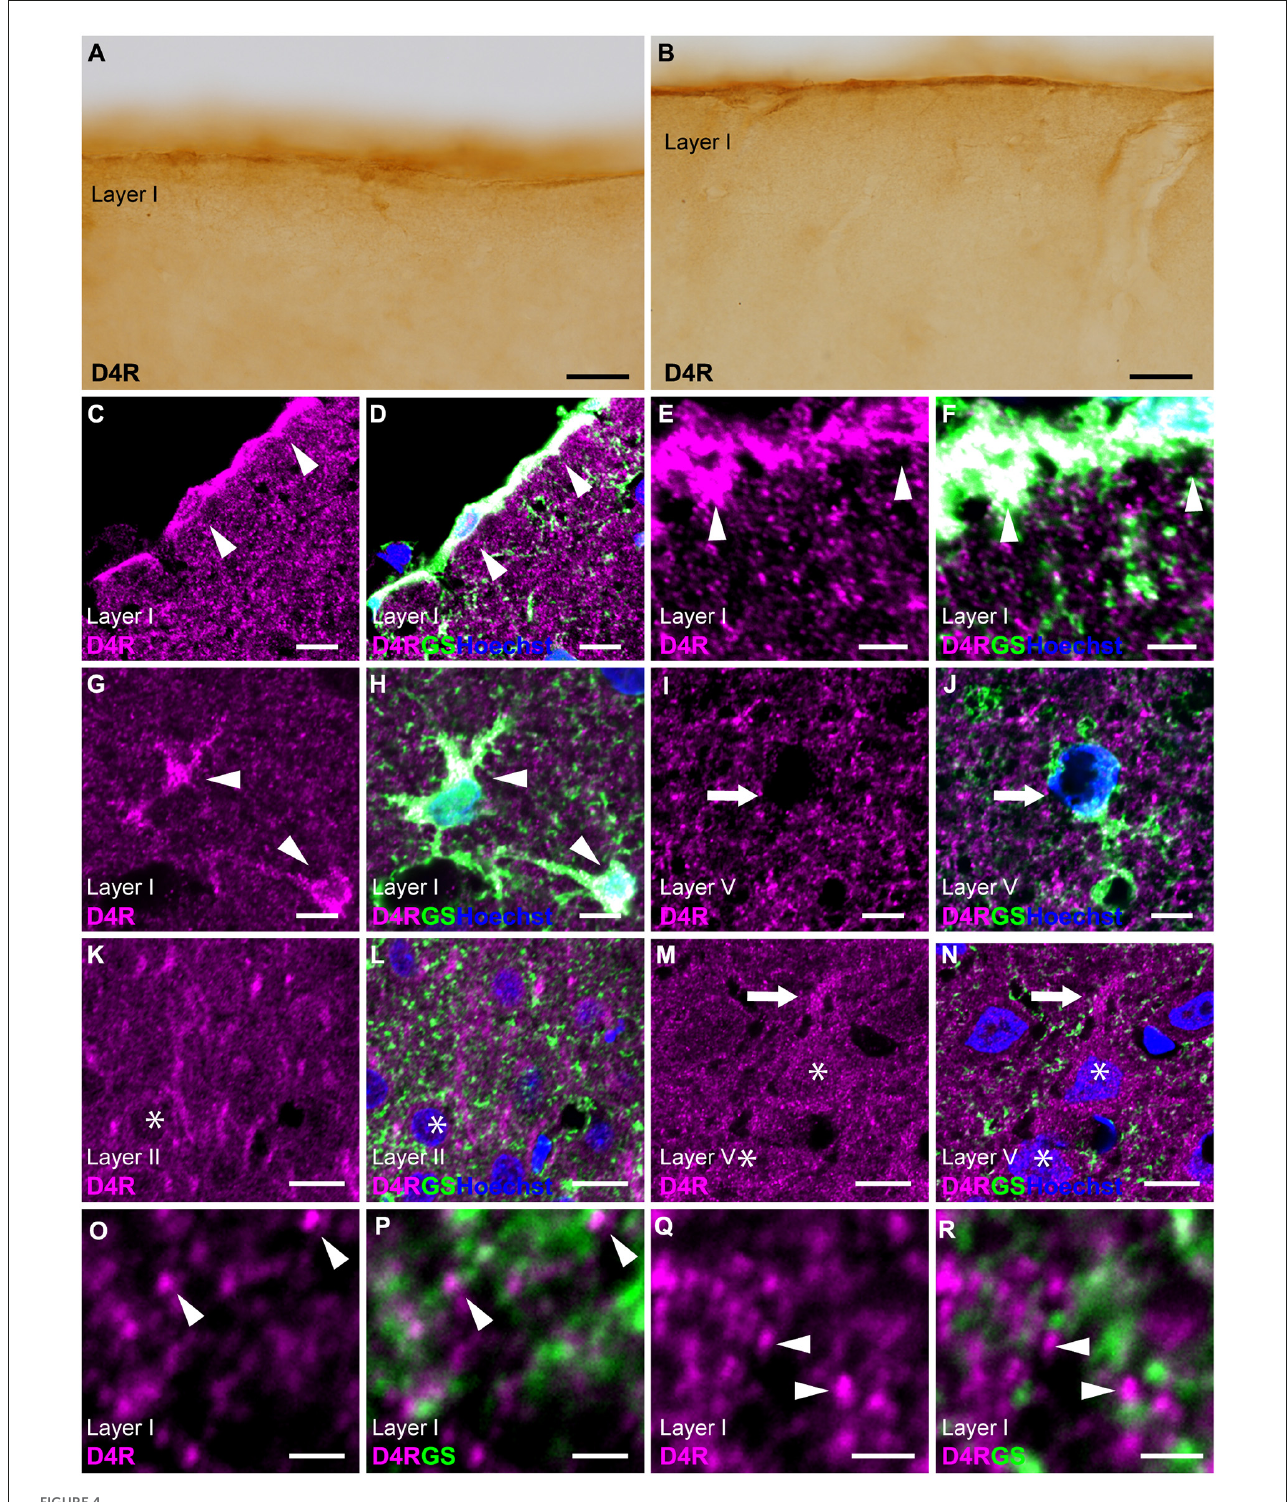
FIGURE4 D4R-immunoreactivityinastrocytes. (A,B) ModerateD4R-immunoreactivitiesofthecorticalsurfaceoftheprelimbic (A) andsomatosensory (B) areas. (C,D) Confocal imaging of double immunostaining for D4R (magenta) and GS (green) indicated strong D4R-immunoreactivities in pial astrocytes (arrowheads) in the prelimbic area. (E,F) Confocal imaging of double immunostaining for D4R (magenta) and GS (green) indicated strong D4R-immunoreactivities in pial astrocytes (arrowheads) in the primary motor area. (G,H) In layer I of the primary motor area, astrocytes showed strong immunoreactivities for D4R (arrows). (I,J) In layer V, weak D4R-immunoreactivities were observed in protoplasmic astrocytes (arrows). (K,L) In layer II of the somatosensory area, D4R-immunoreactivities were observed in GS-negative cells (asterisks). (M,N) In layer V of the primary motor area, D4R-immunoreactivities were observed in a pyramidal cell-like large cell (asterisks) and its process (arrows). (O–R) In layer I of the primary motor area, strong and granular immunoreactivities for D4R were observed (arrowheads), which were in close vicinity of the GS-positive structure (green), but not overlapped. Nuclei were stained with Hoechst33342. Scale bars: 20 µ m (A,B) ; 10 µ m; (C,D,I–N) ; 5 µ m (E–H) ; 2 µ m (O–R)